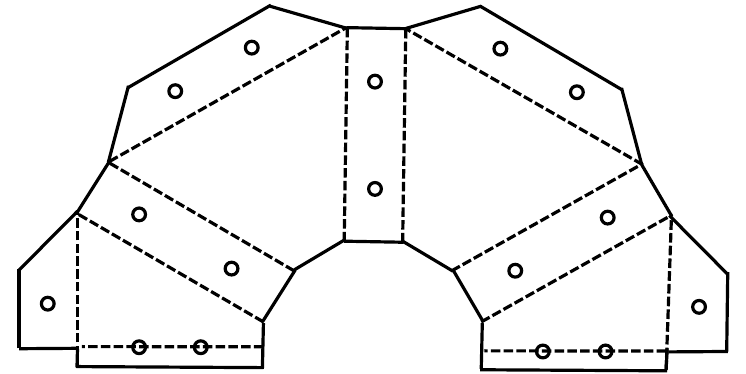
Figure 9. Schematic of the planar part of the truss core.